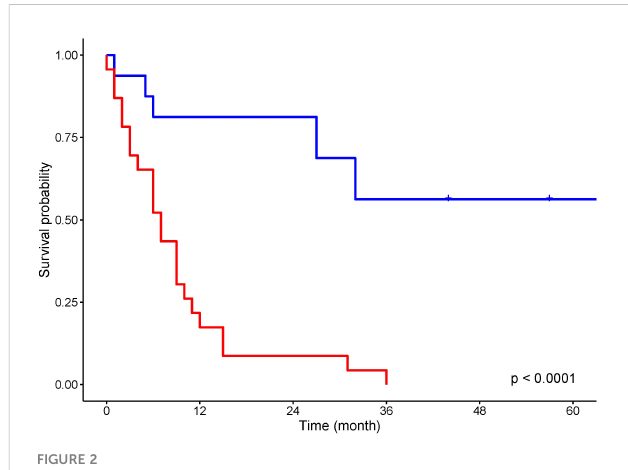
FIGURE 2 Kaplan – Meier analysis for overall survival of patients treated with curative intent (blue) and non curative intent